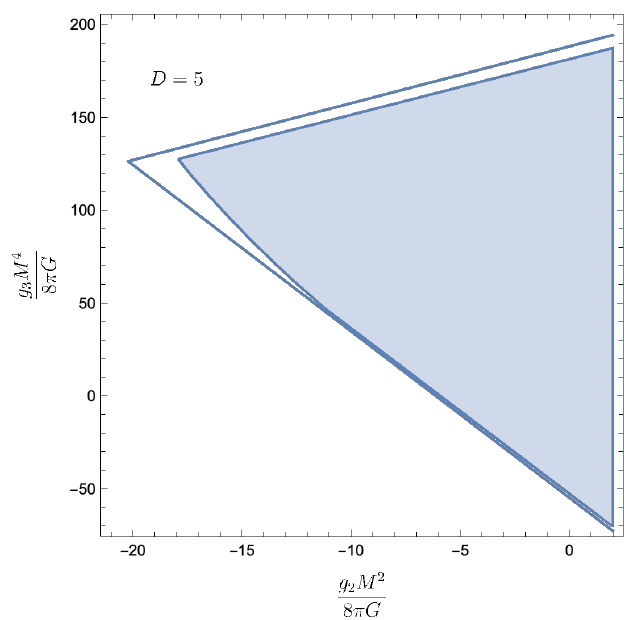
Figure 2. Allowed region (shaded) for g 2 and g 3 from [11], in a theory of a scalar coupled to gravity in flat space in dimensions D = 5 and heavy mass scale M . Asymptotically to the right, the region is a cone which matches the non-gravitational bounds; note the offset to the left. The solid lines show the non-optimal bounds from the simple functionals